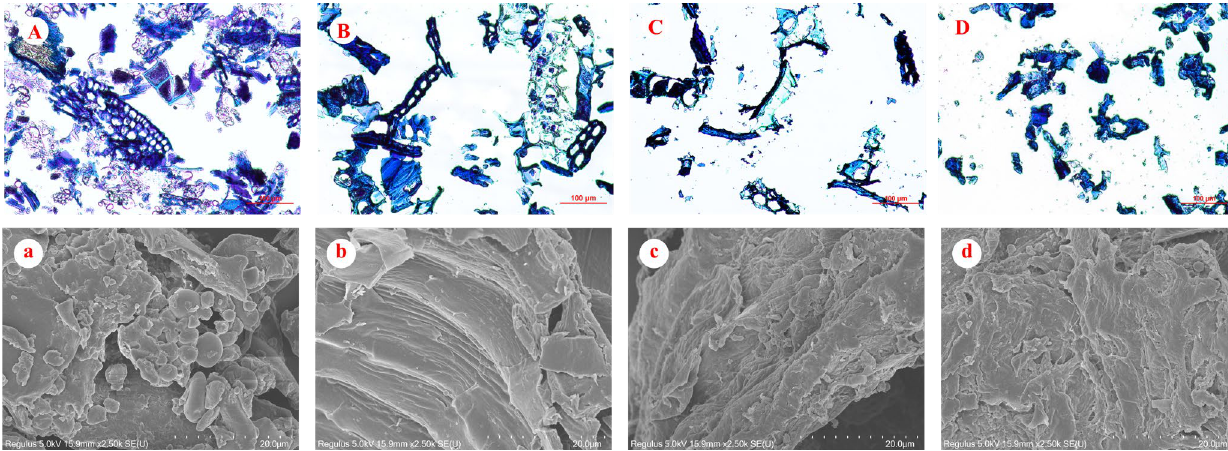
Figure 3. Light microscope images and SEM images of rice bran ( A , a ), H-FC ( B , b ), EH-FC ( C , c ) and E-FC ( D , d ). H-FC is traditional hydrolysis-induced fiber concentrate, EH-FC is extrusion-hydrolysis-induced fiber concentrate, and E-FC is enzymatic extrusion-induced fiber concentrate.